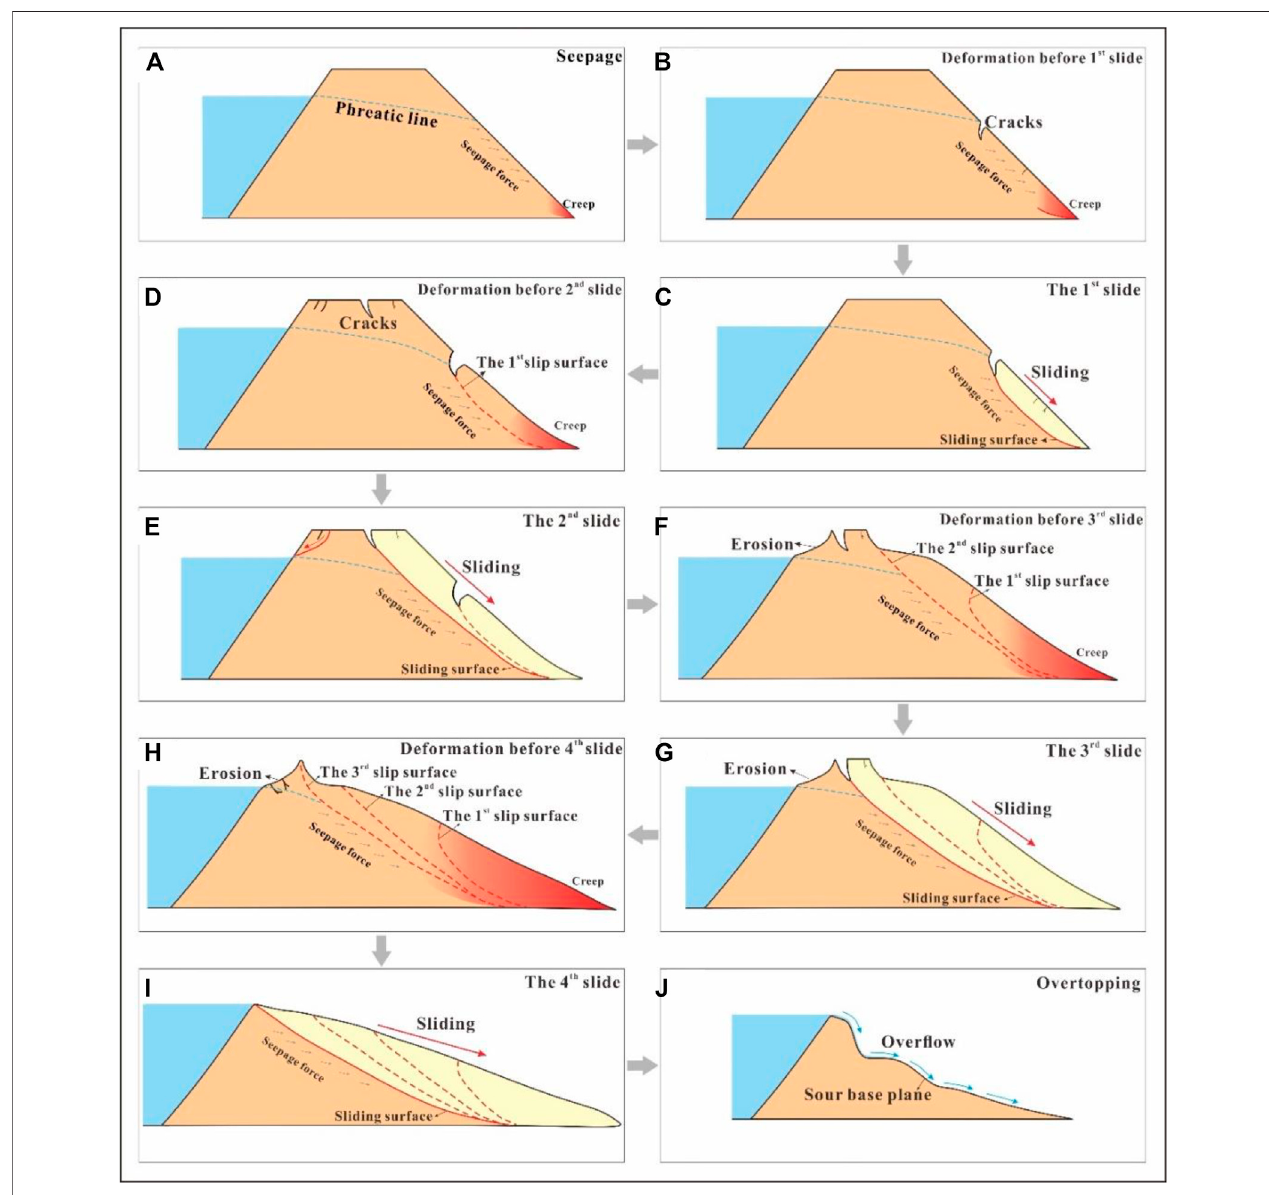
FIGURE15| Formationmechanismoftheprogressivefailureofmodeldam. (A) Seepage, (B) deformationbeforethe1stslide, (C) 1stslide; (D) deformationbefore the 2nd slide, (E) 2nd slide, (F) deformation before the 3rd slide, (G) 3rd slide, (H) deformation before the 4th slide, (I) 4th slide, and (J) overtopping.